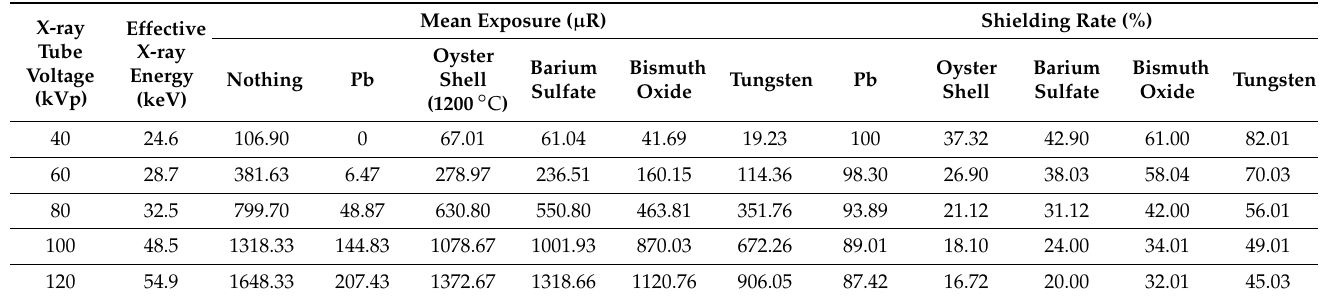
Table 3. Comparison between the shielding efficiencies of eco-friendly shielding sheets.